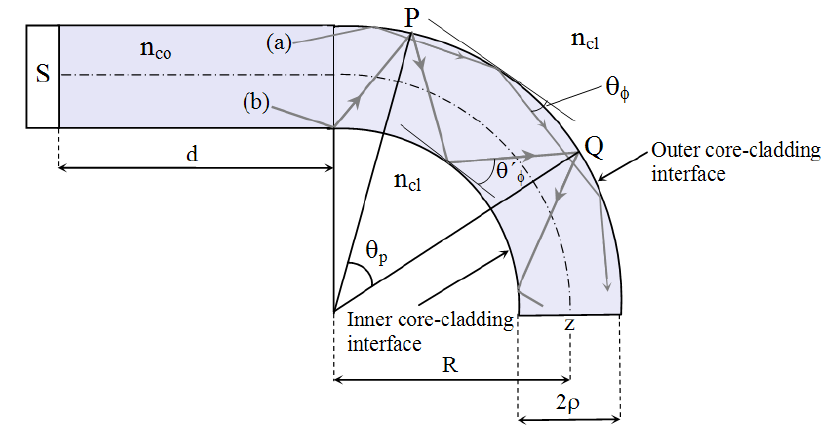
Figure 1. Guided rays in a curved zone of a planar